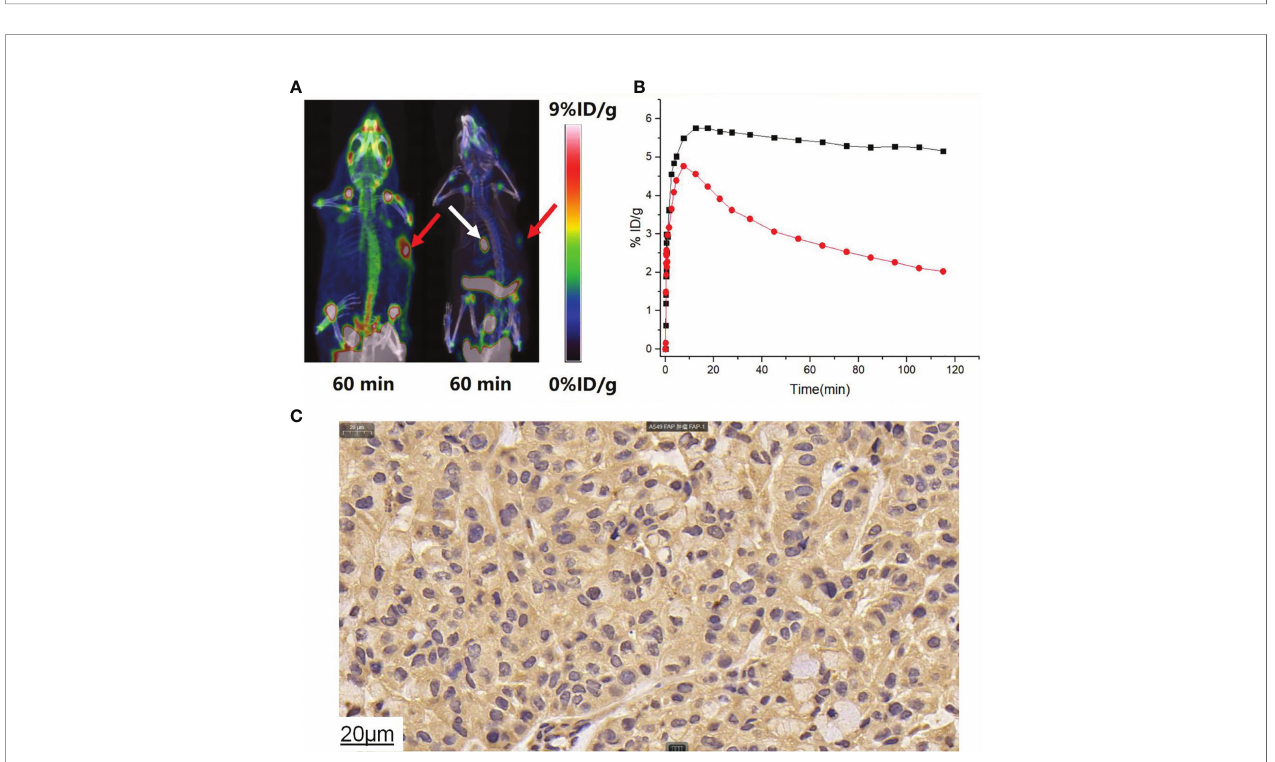
FIGURE 6 | (A) [ 18 F]AlF-FAPT and [ 18 F]FAPI-42 took contrast images during 60min, the red arrows points to the tumor and the white arrow points to the gallbladder. (B) The time-dependent uptake curves of [ 18 F]AlF-FAPT (black) and [ 18 F]FAPI-42 (white) in the tumor. (C) IHC staining results showed A549FAP tumor tissue with high FAP expressing (40× ampli fi